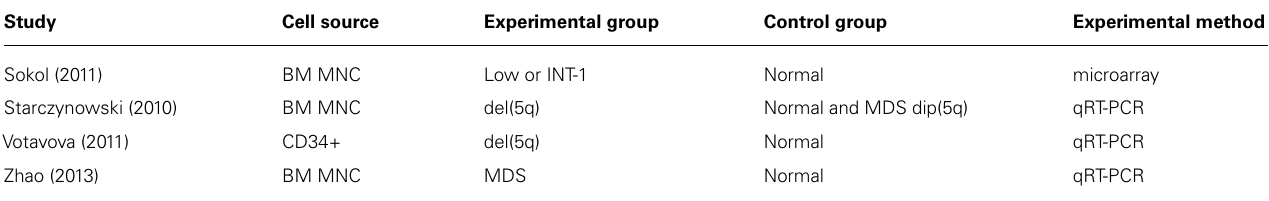
Table 1 | Evidence of low miR-146a expression in